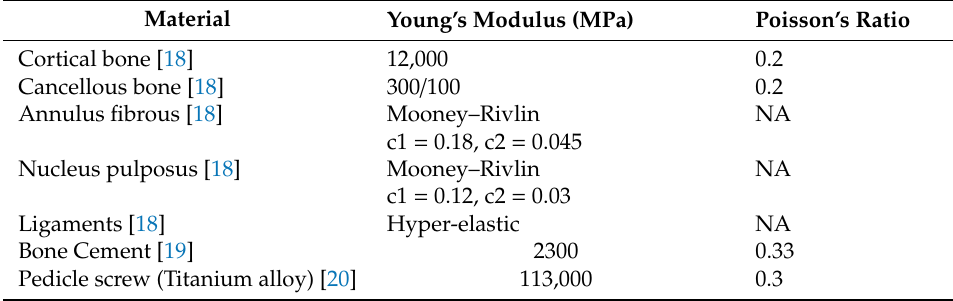
Figure 1. Finite element model of the ( a ) intact (INT) lumbar spine implanted with ( b ) spinal posterior fixation system, cement augmentation at the L3 vertebra and ( c ) the cement-augmented pedicle screws at L2 and L4 in AwC-TSF-S. *The ligaments are: ALL, anterior longitudinal ligament; PLL, posterior longitudinal ligament; TL, transverse ligament; LF, ligamentum flavum; ISL, interspinous ligament; SSL, supraspinous ligament; CL, capsular ligament. Table 1. The material properties of intact spine and instrumented models.